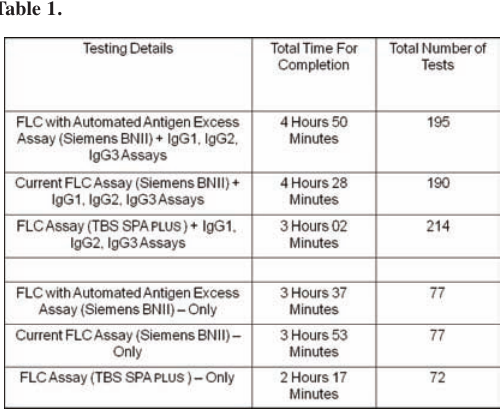
Table 1: Total time required to carry out assessment of calibration curves, QC & serum samples. Table